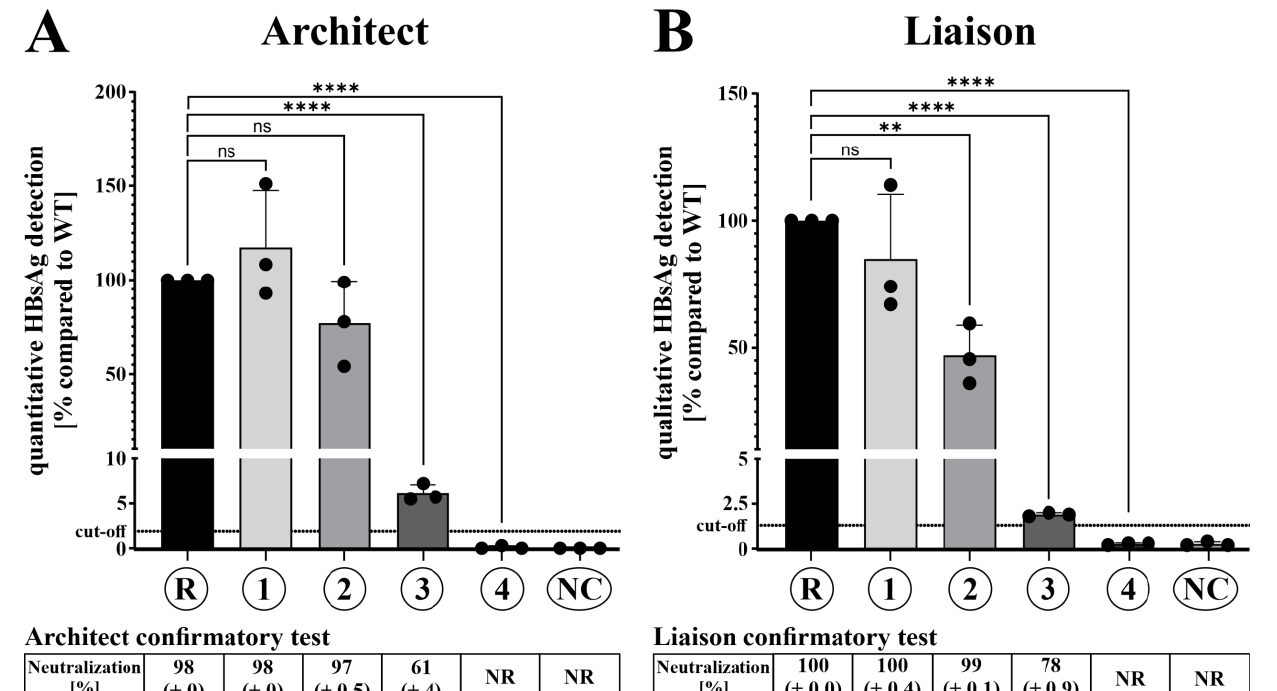
Figure 3. Detectability of SHBs is severely impaired by the combination of hyperglycosylation and immune escape variants. ( A ) Top panel: HepG2 cells were transiently transfected with SHBs-expressing plasmids and supernatants were collected four days after transfection. SHBs in the supernatants was adjusted to equal amounts (as quantified by immunoblot) and measured in the quantitative HBsAg assay (Abbott ARCHITECT). Bottom panel: supernatants containing equal amounts of SHBs (as quantified by immunoblot) were tested in the HBsAg confirmatory test (Abbott ARCHITECT). ( B ) Top panel: supernatants containing equal amounts of SHBs (as quantified by immunoblot) were measured in the qualitative HBsAg assay (DiaSorin Liaison). Bottom panel: supernatants containing equal amounts of SHBs (as quantified by immunoblot) were tested in the HBsAg confirmatory test (DiaSorin Liaison). All panels show the results of three independent experiments. R = SHBs of subgenotype D3 reference strain; 1/2/3/4 = SHBs containing aa1-99 of the reference strain and aa100-226 of a patient-derived sequence of cluster 1/2/3/4, respectively (also refer to Figure 2A). NC = negative control (supernatant of empty pcDNA3.1(+)-transfected cells). NR = nonreactive. ns = not significant, ** = p < 0.01, **** = p < 0.0001 (unpaired t-test).